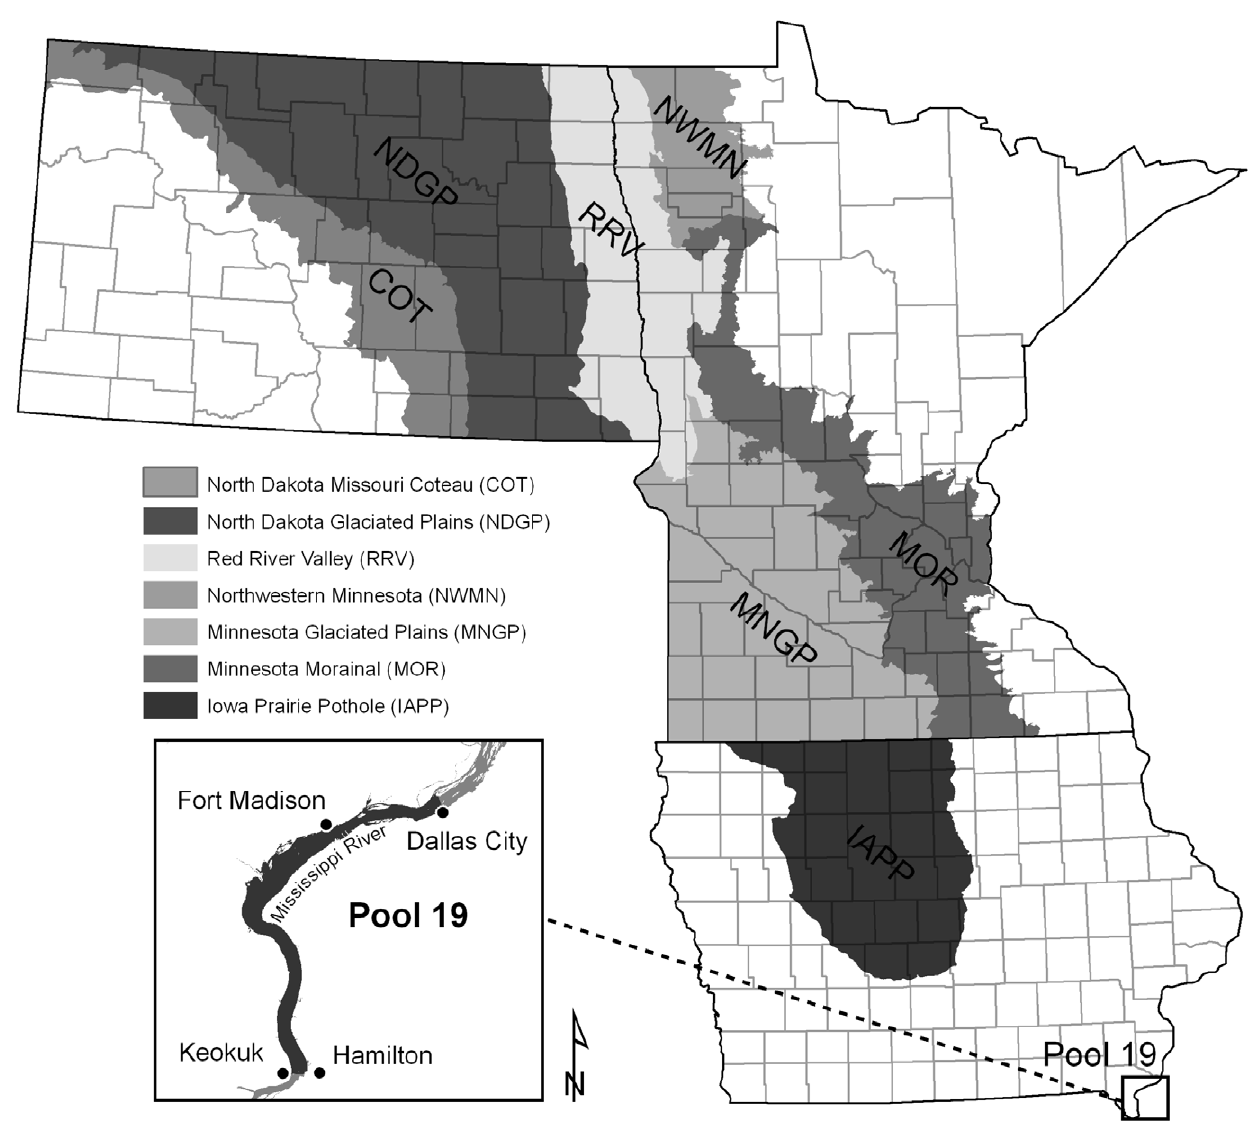
Figure 1. Study area depicting 7 eco-physiographic regions in the upper Midwest. Areas within these eco-physiographic regions were selected randomly for collections of lesser scaup blood samples during springs 2004–2005. Areas in white were not